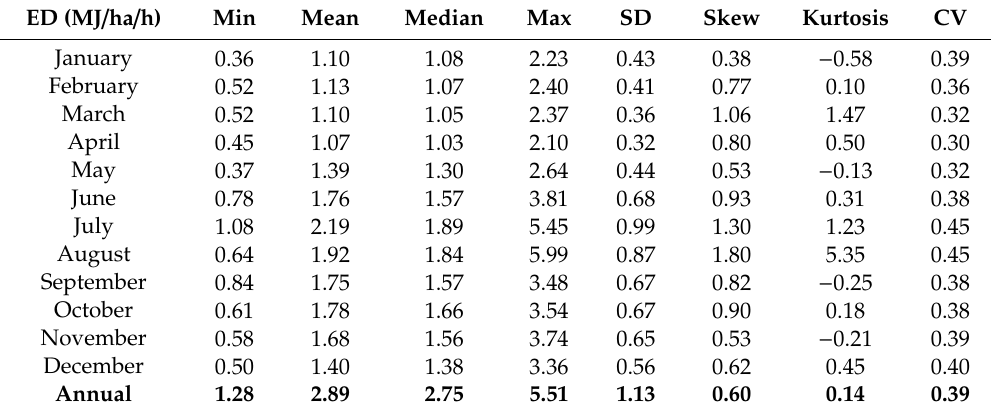
Table 1. Average statistical properties of annual and monthly ED values for the stations used in clustering analysis. SD is an abbreviation for standard deviation and CV for coe ffi cient of variation (the ratio of the standard deviation to the